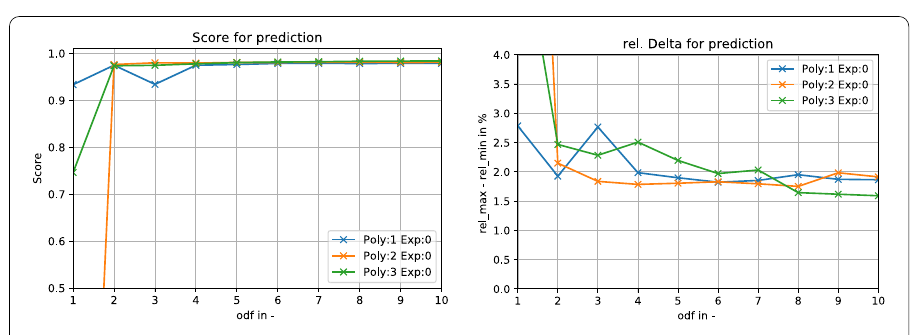
Fig. 14 Brakedisk: convergence of quality measure RSME-score and (cid:2) rel for brakedisk